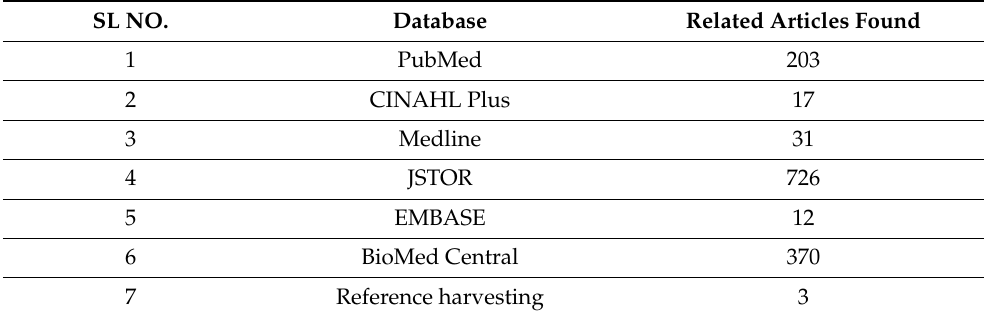
Table 3. Comprehensive